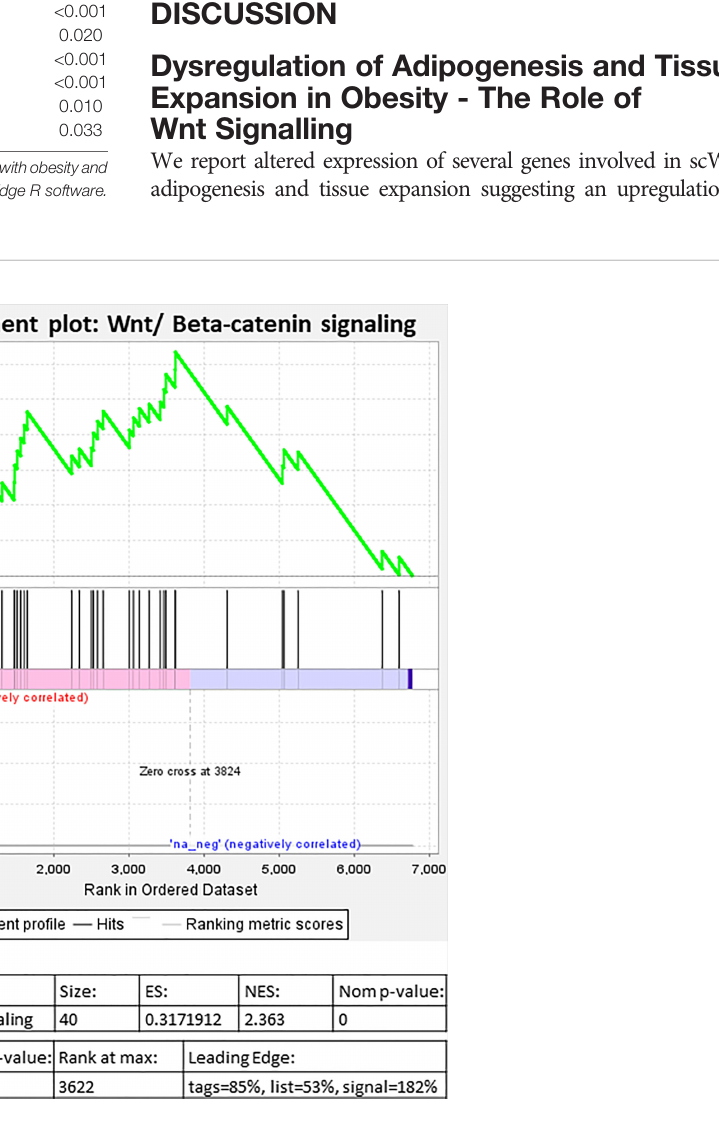
FIGURE 3 | Gene set enrichment analysis (GSEA) of differentially expressed genes in individuals living with obesity at week-0: Enrichment plot for Wnt/ b -Catenin signalling.